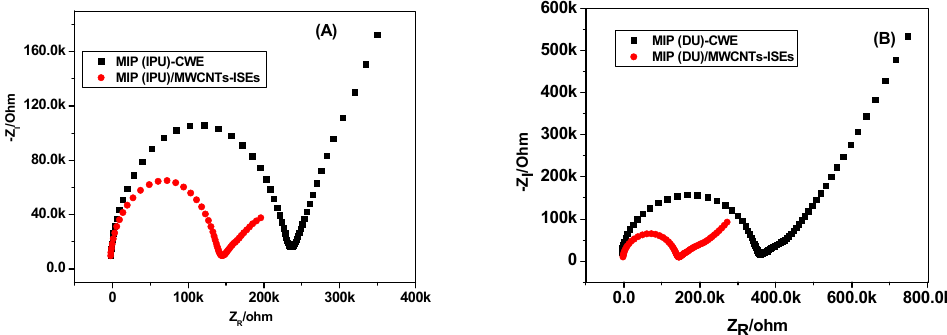
Figure 8. ( A ) Impedance plots of MIP (IPU) / MWCNTs-ISEs (red) and MIP (IPU)-coated-wire electrodes (CWEs) (black) in the 10 − 4 M IPU solution. ( B ) Impedance plots of MIP (DU) / MWCNTs-ISEs (red) and MIP (DU)-CWE (black) in the 10 − 4 M DU solution. Conditions: the frequency ranges from 100 kHz to 0.01 Hz and the disturbance amplitude is 10 mV.